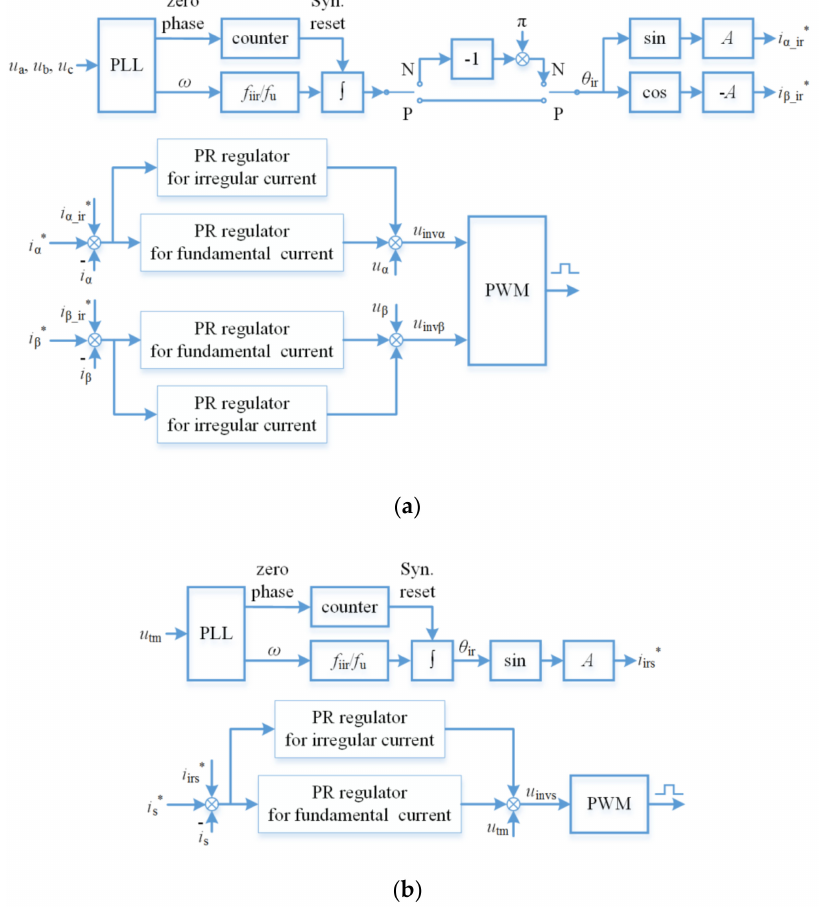
Figure 10. Implementation of the proposed solution. ( a ) For three-phase inverters; ( b ) For single-phase